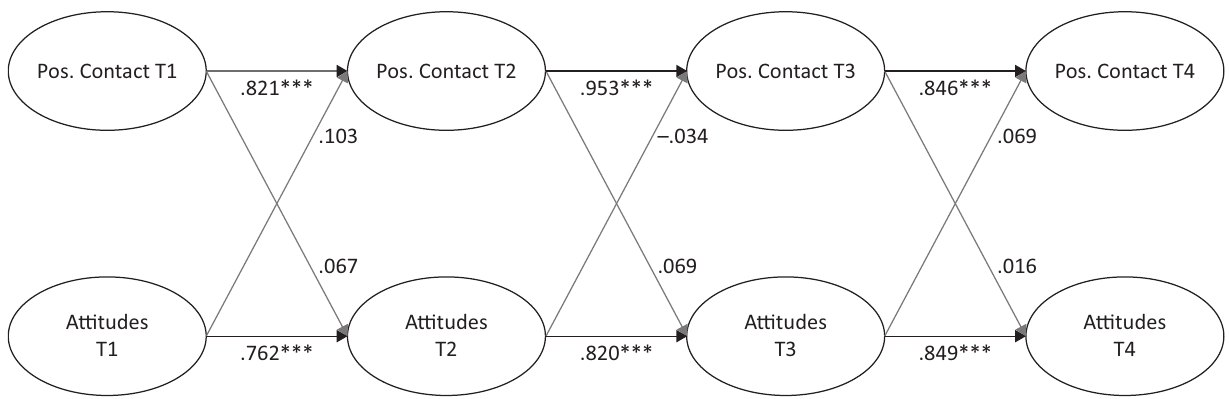
Figure 1. Conventional CLPM for foreigners. Notes: Standardized regression coefficients are reported. The model is sim- plified and depicts only the structural relations of interest, omitting the underlying measurement model and covariations between constructs at the same timepoint. Significant paths are depicted darker. *** p <